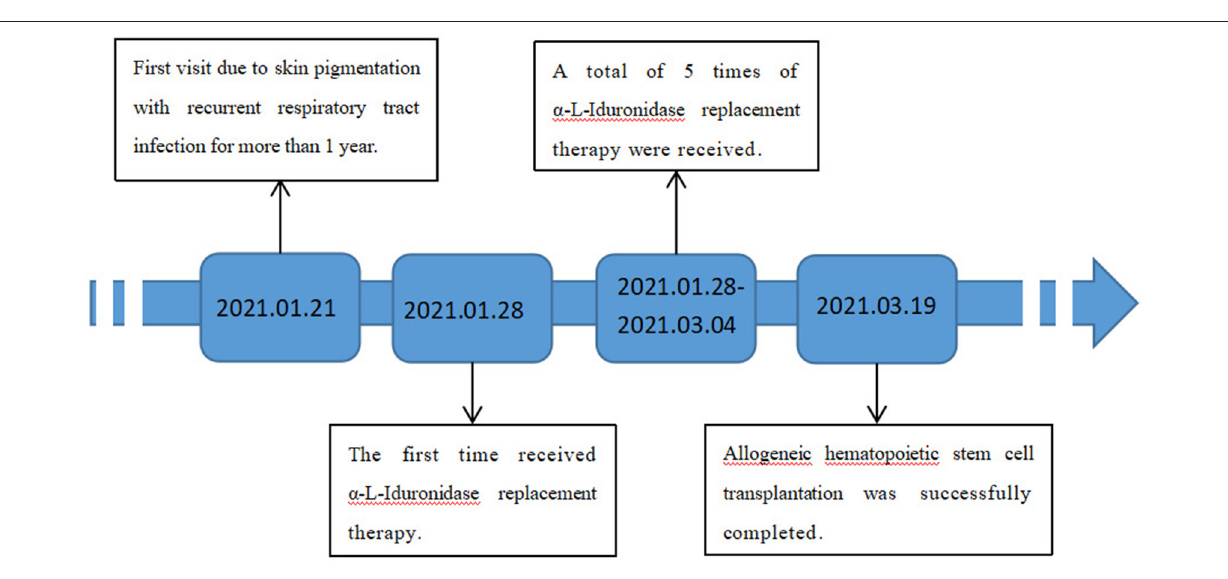
FIGURE 3 | Timeline of the patient’s treatment